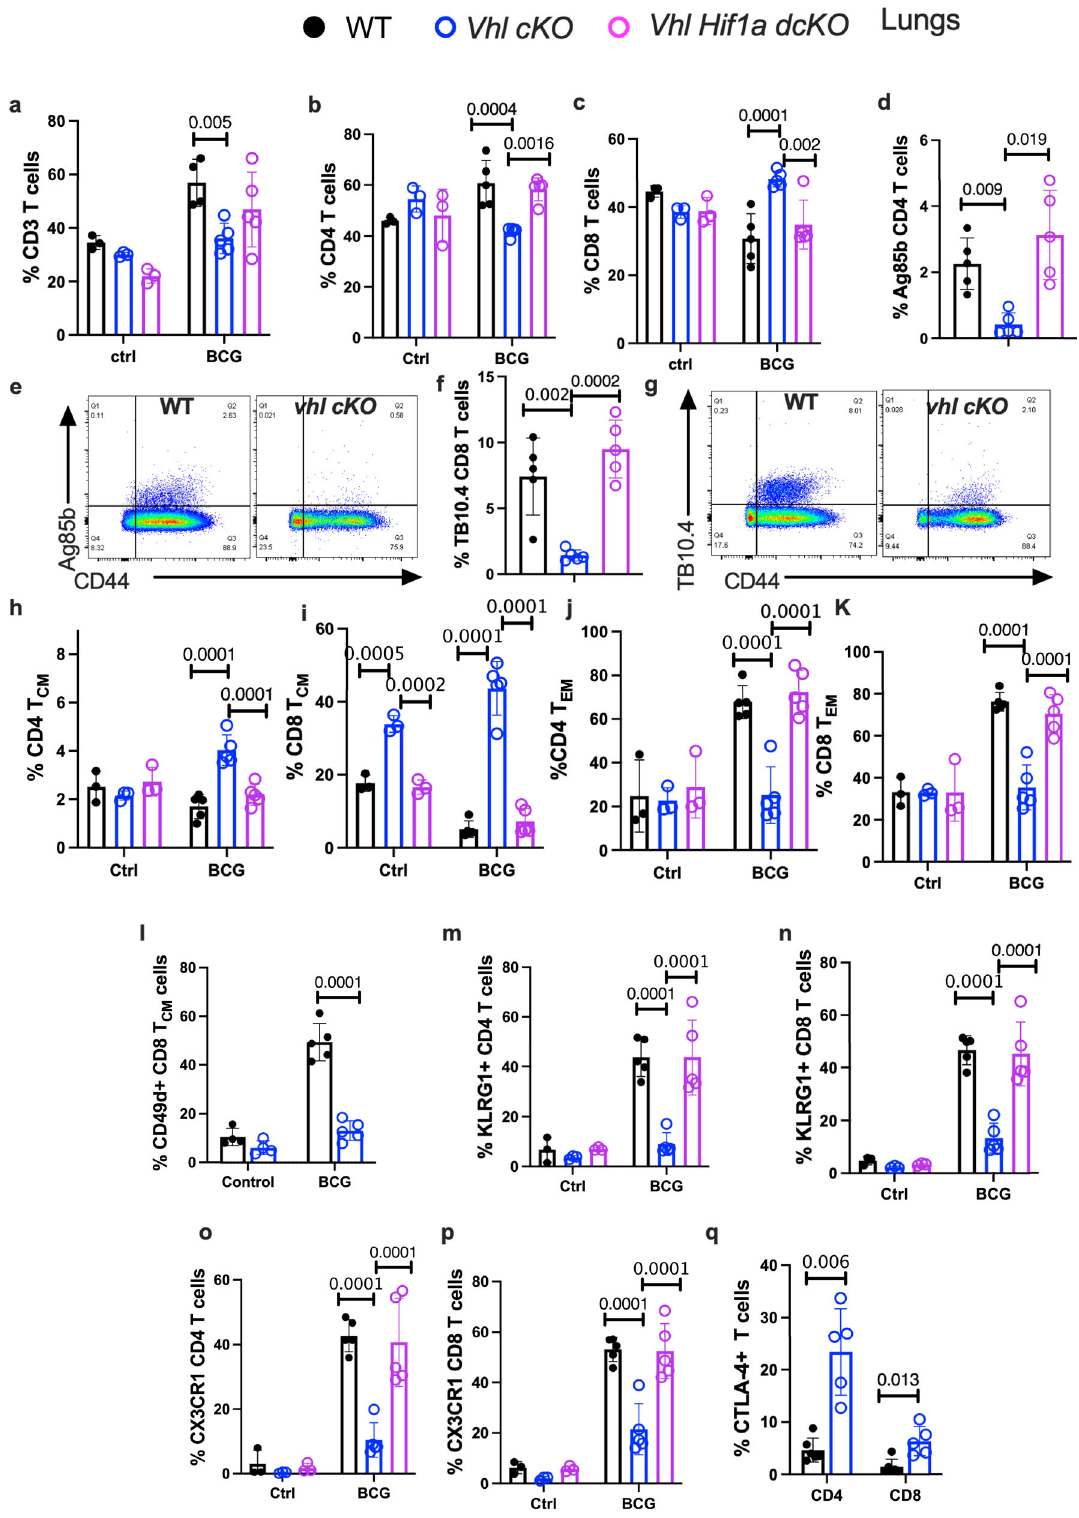
Fig.8|HIF-1stabilizationinTcellsimpairstheresponsestoimmunizationwith BCG.a – c Thefrequencyoftotal( a ),CD4( b )andCD8( c